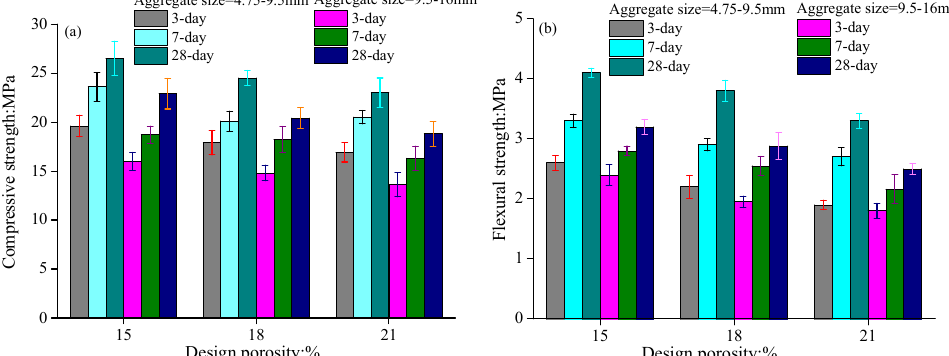
Figure 12. Effect of the design porosity on the strength of pervious concrete. ( a ) Compressive strength; ( b ) Flexural strength. The figure shows an average value and standard deviation of three specimens.